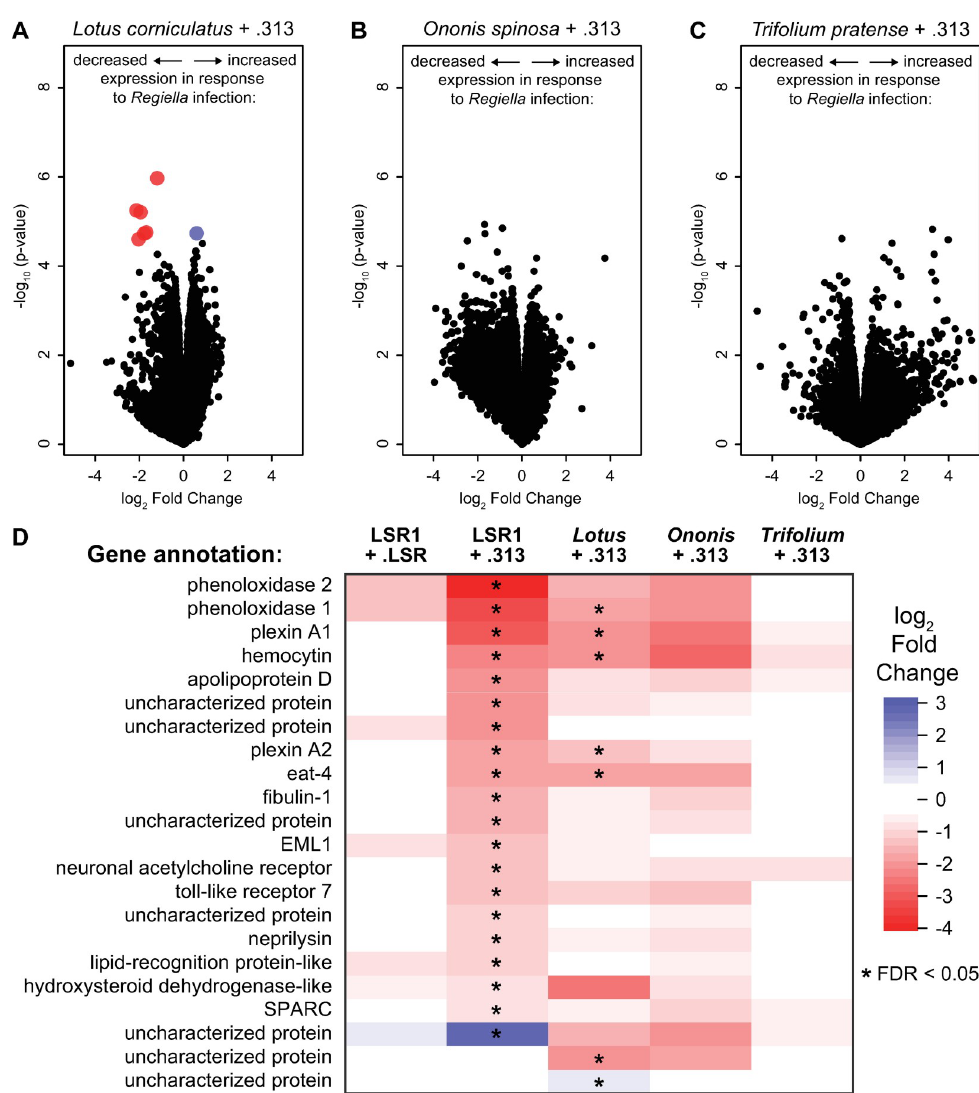
Fig 3. Gene expression across aphid biotypes. A-C: Volcano plots of expression data comparing control vs. Regiella - infected aphids. Each expressed gene in the aphid genome is represented by a point. The x-axes show the log 2 fold change of each gene, with points to the right side of each plot indicating increased expression in the presence of symbionts, and points to the left showing decreased expression. The y-axes show the -log 10 of the p-values indicating statistical significance of each gene’s expression change. Colored points are those where the expression change was found to be statistically significant at FDR < 0.05. Panels A, B, and C show plots for the Lotus , Ononis , and Trifolium genotypes respectively, as shown along the top of the figures. D: A heat-map comparing gene expression in response to Regiella strain .313 infection across host genotypes. The 22 differentially expressed genes identified in the LSR1 transcriptome, above, are listed to the left of the figure. Colors represent the log 2 fold change of these genes in response to Regiella as indicated in the key to the right of the figure (with red panels representing a decrease in expression, and blue indicating an increase in expression). The five transcriptomes generated in this study are shown in each column, as indicated at the top of the figure. Statistical significance of each gene is indicated by an asterisk at an FDR < 0.05. each aphid genotype serving as the maternal line. We used qPCR to measure expression of